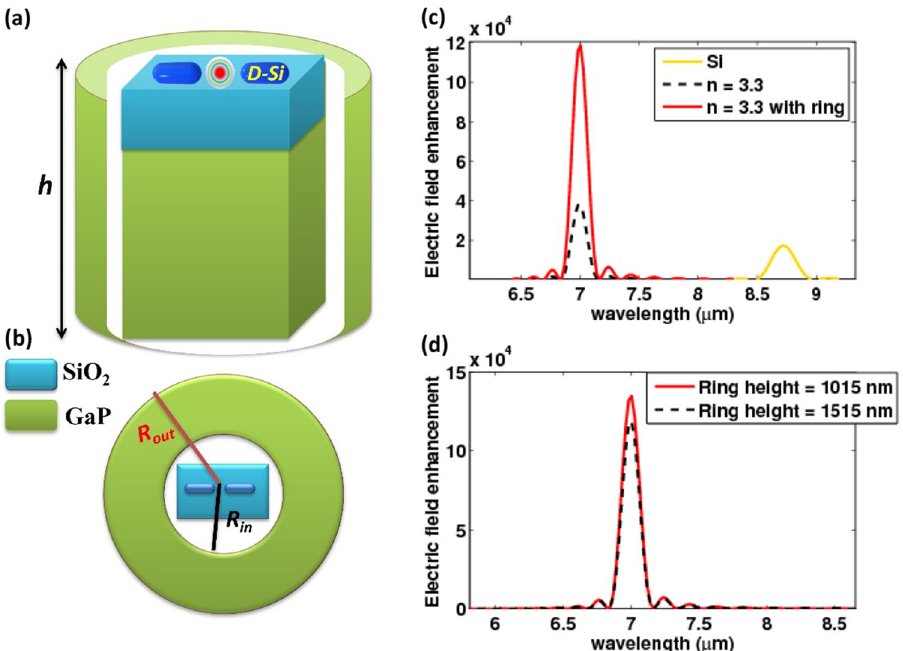
Figure 11. ( a ) cross sectional view of the nanorod antenna with a ring, ( b ) a top view of the nanorod antenna with a ring ( c ) wavelength-dependent local field enhancement of the hybrid nanoantenna compared to the hybrid nanoantenna with a ring and the nanoantenna with a silicon substrate, and ( d ) local field enhancement as a function of wavelength for different ring